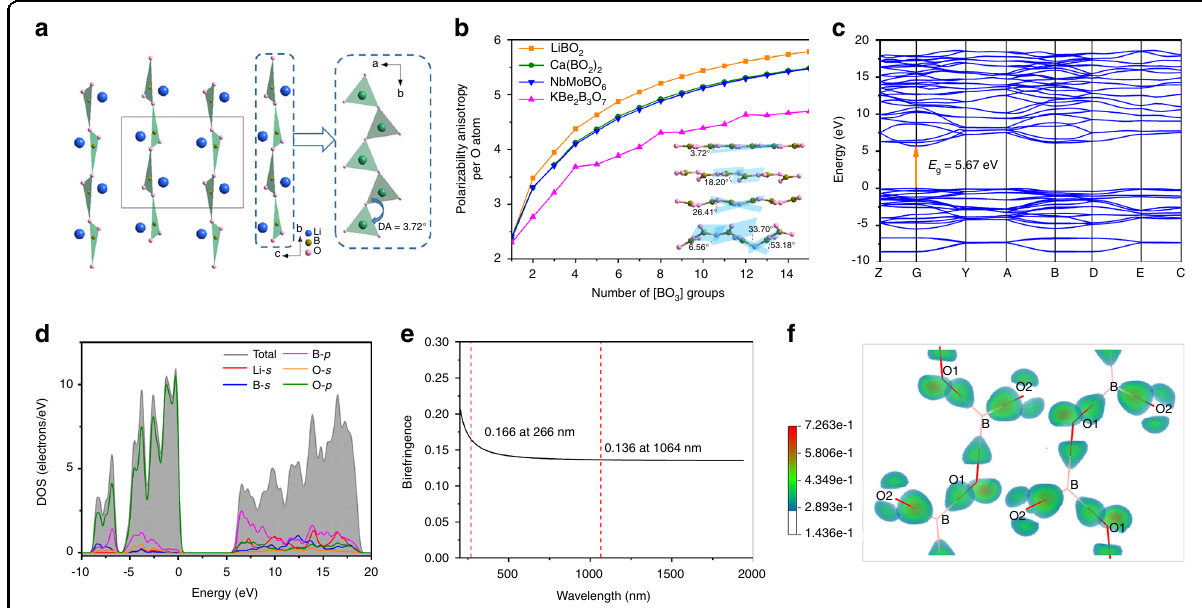
Fig. 4 Crystal structure and theoretical calculations on structure-property relations of LiBO 2 . a Crystal structure of LiBO 2 viewed along a -axis and the [BO 2 ] ∞ chains with a dihedral angle (DA) of 3.72 ° between adjacent [BO 3 ] planes. b Average polarizability anisotropy per oxygen atom of [BO 2 ] ∞ chains with different dihedral angles. The number of [BO 3 ] groups were chosen from 1 to 15 in the calculation. Structural models for Ca(BO 2 ) 2 , NbMoBO 6 and KBe 2 B 3 O 7 are retrieved from Refs. 41,56,57 , respectively. c Electron band structure of LiBO 2 . The arrow indicates the direct band gap. d Total and partial density of states (DOS) of LiBO 2 . e Calculated birefringence of LiBO 2 . f Electron density difference of LiBO